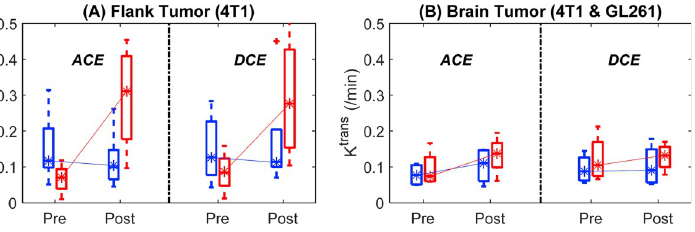
Fig 5. Treatment responses comparison between 4T1 tumors in the flank and 4T1/GL261 tumors in the brain. (a) Median tumor K trans changes before and after treatment for flank 4T1 tumor. Blue boxplot: control group ( n = 5), red boxplot: treated group ( n = 4). (b) Median tumor K trans changes before and after treatment for brain 4T1/GL261 tumors. Blue boxplot: control group ( n = 4), red boxplot: treated group ( n = 4).